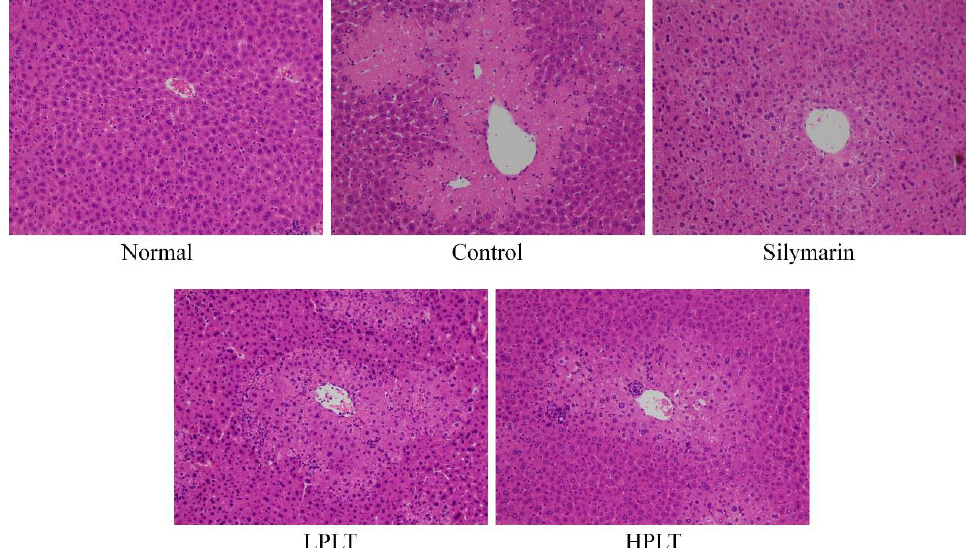
Figure 1. Hematoxylin and eosin (H&E) pathological observation of hepatic tissue in experimental with CCl 4 -induced hepatic damage. Magnification: 100 × . Silymarin group: 50 mg/kg body weight (b.w.) silymarin treatment dose; LPLT group: 50 mg/kg b.w. polyphenols of Liubao tea (PLT) low